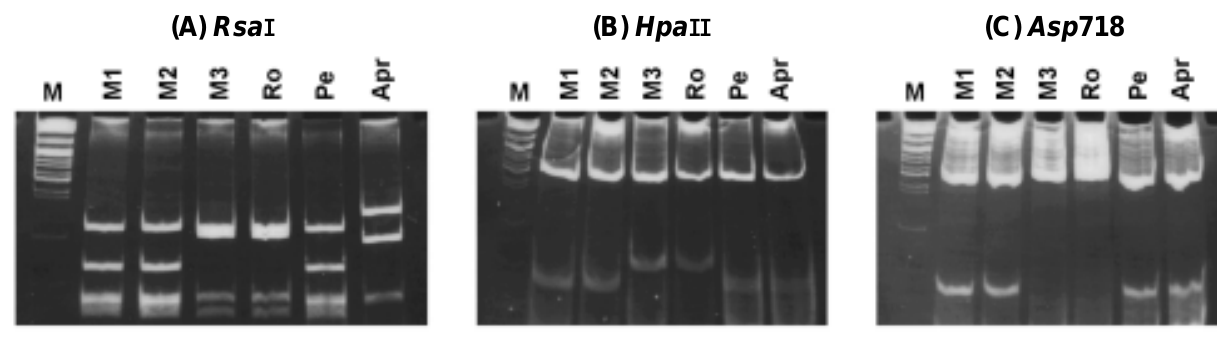
Fig. 1. Differentiation among Prunus necrotic ringspot virus isolates by restriction endonuclease cleavage of PCR products. PCR products amplified from total RNA extracted from isolates M1, M2, Pe, M3, Ro and Apr were cleaved with Rsa I (A), Hpa II (B) and Asp 718 (C). Digests were fractionated in 6% PAG and stained with ethidium bromide. M, DNA size marker III (Boehringer, Mannheim,